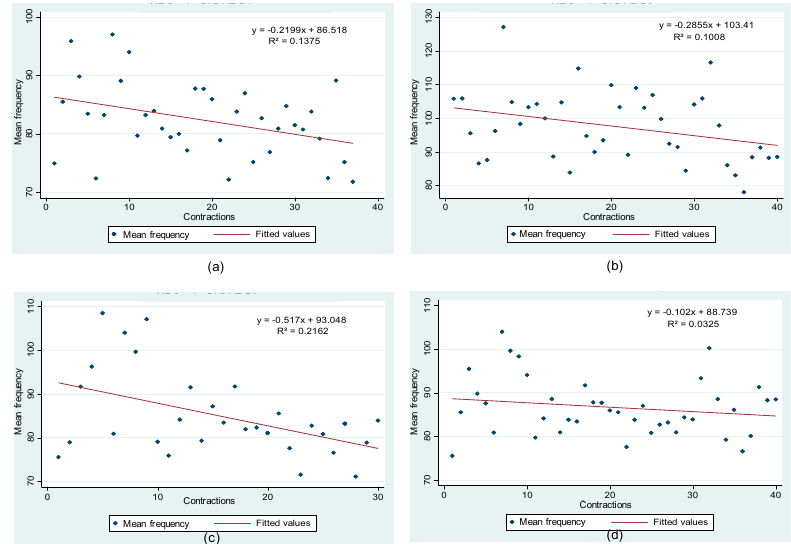
Figure 6. Results obtained with linear regression in the frequency analysis for player 7: ( a ) Routine 1; ( b ) Routine 2; ( c ) Routine 3; ( d ) Total.